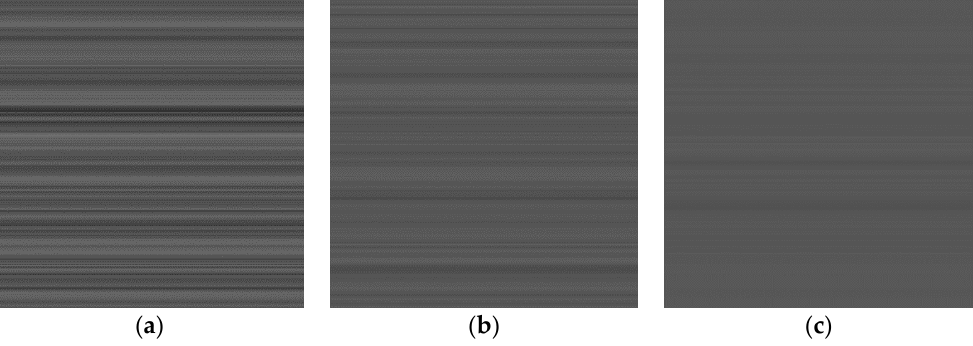
Figure 14. Correction result image of the evaluation image of Figure 10b with the steady-mode output of various ICS radiation. ( a ) steady-mode ICS-1000; ( b ) steady-mode ICS-3000; ( c ) steady-mode ICS-5000.